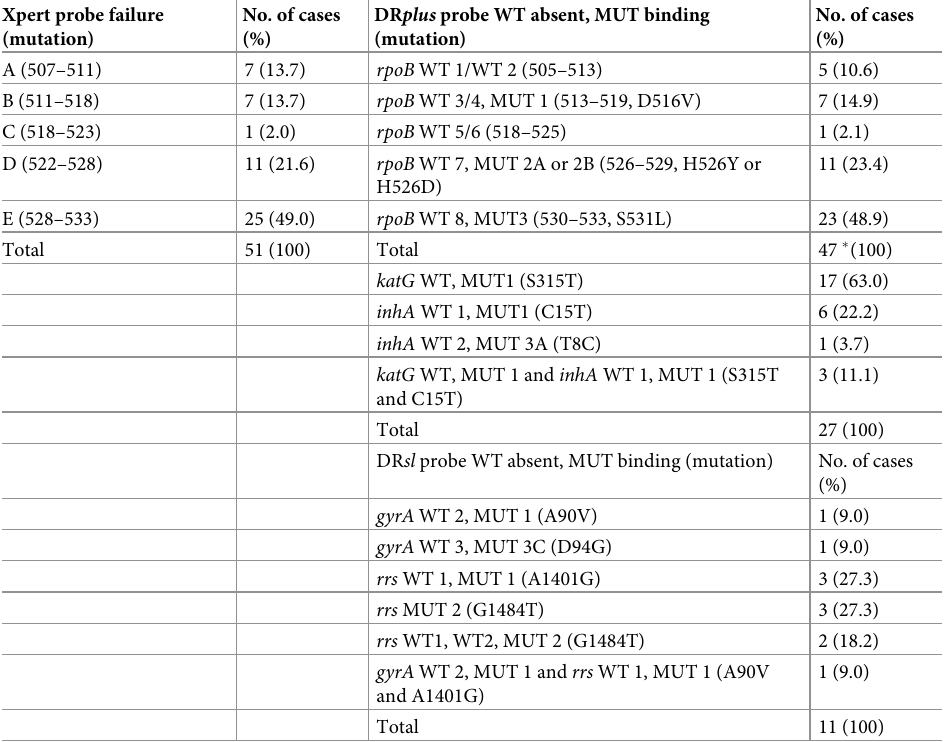
Table 4. Xpert and LPA probe hybridization